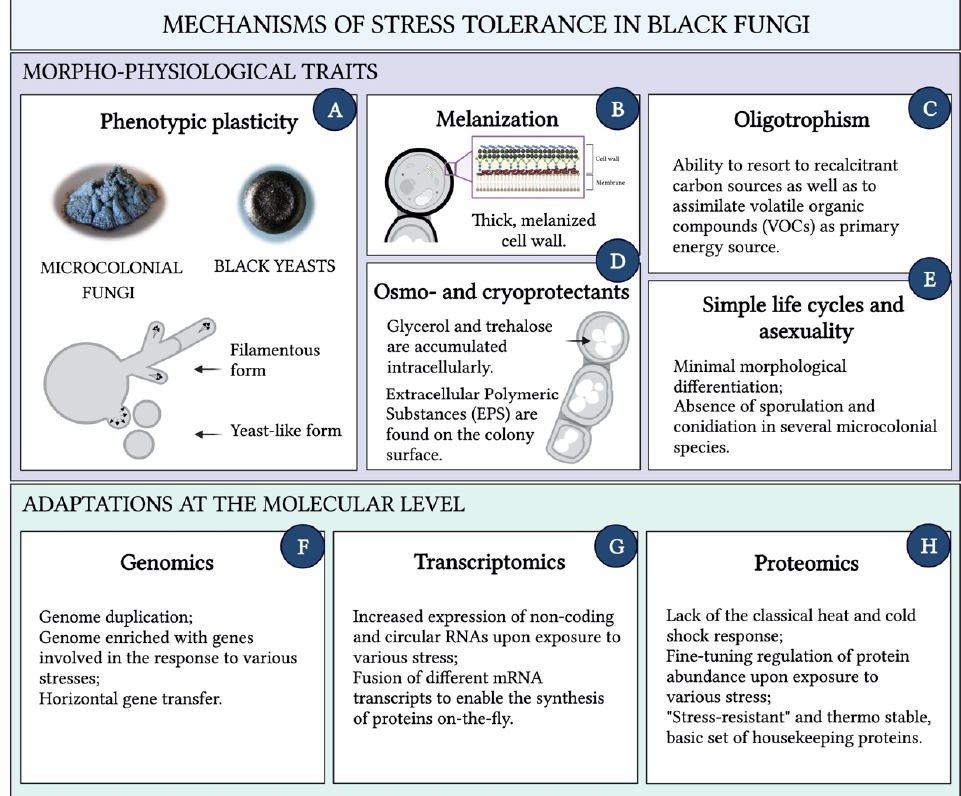
Figure 2. Morphophysiological characteristics and adaptations at the molecular level, that underpin black fungi stress tolerance. The ability to switch between filamentous and yeast-like forms and to grow meristematically ( A ); Deposition of melanins in the multilayered cell wall. Major constituents of the wall are shown. From bottom to top: the chitin (in red)/glucan matrix, melanin (in black) and the glycoprotein-rich outer layer. The composition of the cell wall varies between species as well as the location of the melanin layer ( B ); The aptitude to thrive in environments in which factors required for growth are scarce ( C ); The synthesis of life-saving compounds, which are accumulated both intra- and extracellularly. Large intracellular globules of trehalose and glycerol can fill the whole cytoplasm ( D ); Energy-saving strategies to minimize efforts at both the morphological and physiological level under unfavorable life conditions ( E ); Molecular mechanisms for stress-resilience at the genomic, transcriptomic, and proteomics level ( F – H ). Created with BioRender.com.